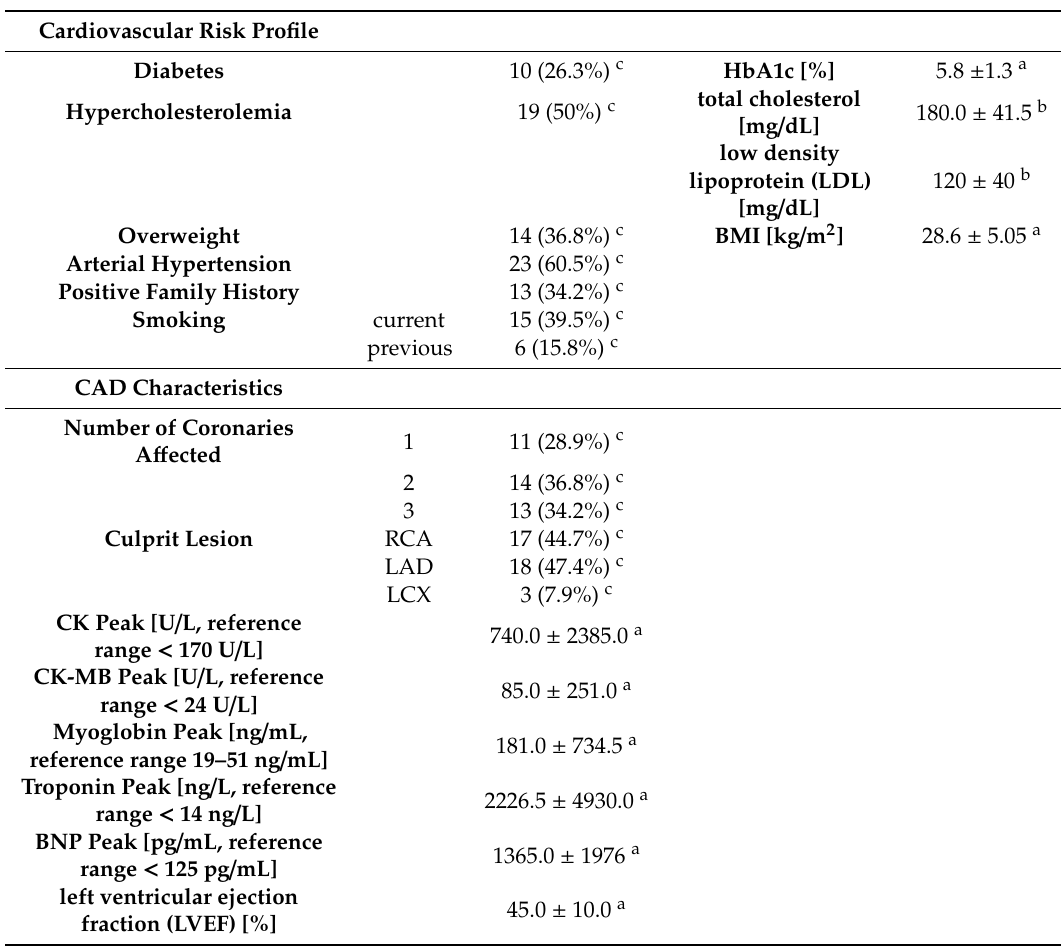
Table 2. Coronary artery disease (CAD) characteristics in the ST-elevation myocardial infarction (STEMI) cohort. a Presented as median ± interquartile range, b presented as mean ± standard deviation, c number of patients (with percentage based on the number of patients with a non-missing value for that characteristic. Hypercholesterolemia was defined as total cholesterol > 200 mg / dL or on medication. For creatine kinase (CK), creatine kinase myocardial band (CK-MB), myoglobin, troponin, and brain natriuretic peptide (BNP), the peak values within the first 24 h after myocardial infarction are